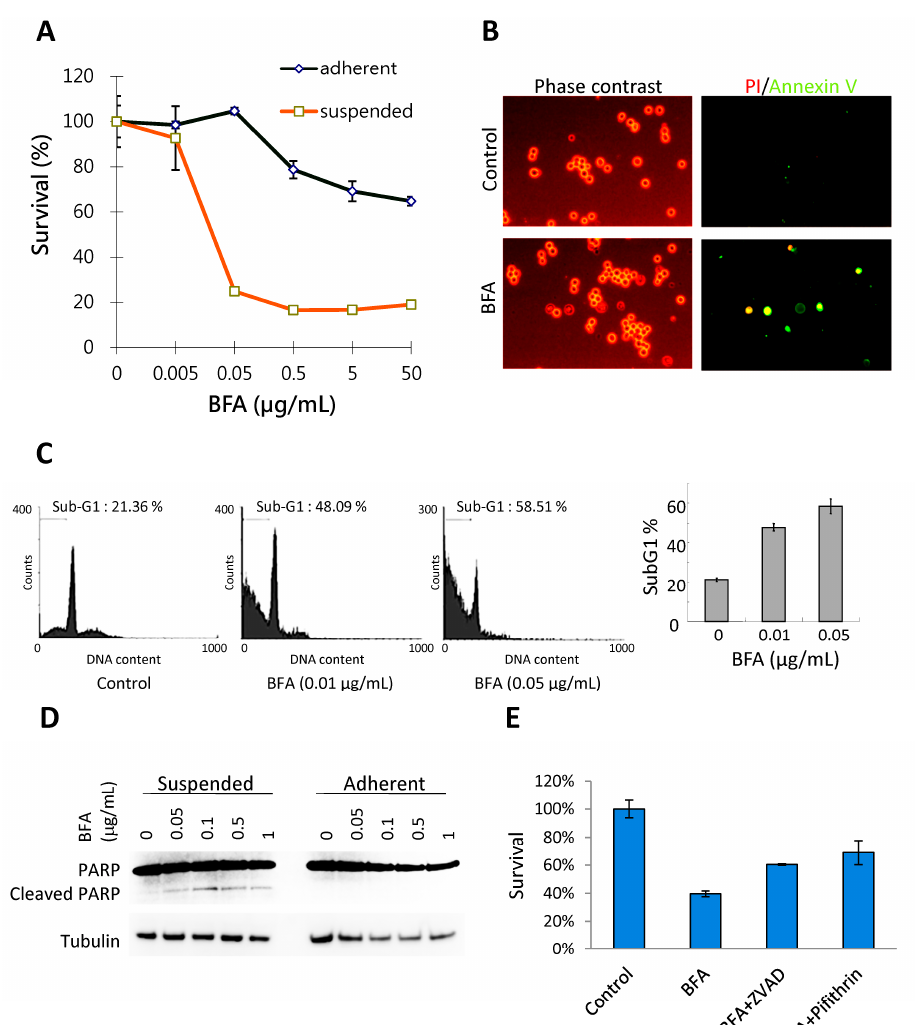
Figure 1. BFA induced anchorage-independent cell death in MDA-MB-231 breast cancer cells. ( A ) Survival curves of suspended or adherent MDA-MB-231 cells treated with 0–50 μ g/mL BFA for 48 h as determined by WST-1 assay (mean ± SD, n = 3) ( B ) PI − /Annexin V + apoptotic cells can be detected in suspension cultures treated with 0.1 μ g/mL BFA for 4 h under a fluorescent microscope. ( C ) Flow cytometric analysis indicated that BFA treatments at 0.01 and 0.05 μ g/mL for 24 h increased the sub-G1 fraction of suspended MDA-MB-231 cells from 22% ± 1.34% to 47% ± 2.71% and 58.52% ± 3.32%, respectively. (mean ± SD, n = 3). ( D ) Cleaved PARP fragments could be detected by Western blotting in suspended MDA-MB-231 cells treated with 0.05–1 μ g/mL BFA for 24 h but not in adherent cells. ( E ) Pretreatment with 100 μ M Z-VAD-FMK or 20 μ M Pifithrin- α increased the survival of cells in the presence of 0.05 μ g/mL BFA from 40.16% ± 0.83% to 61.05% ± 0.57% and 74.52% ± 5.34%,